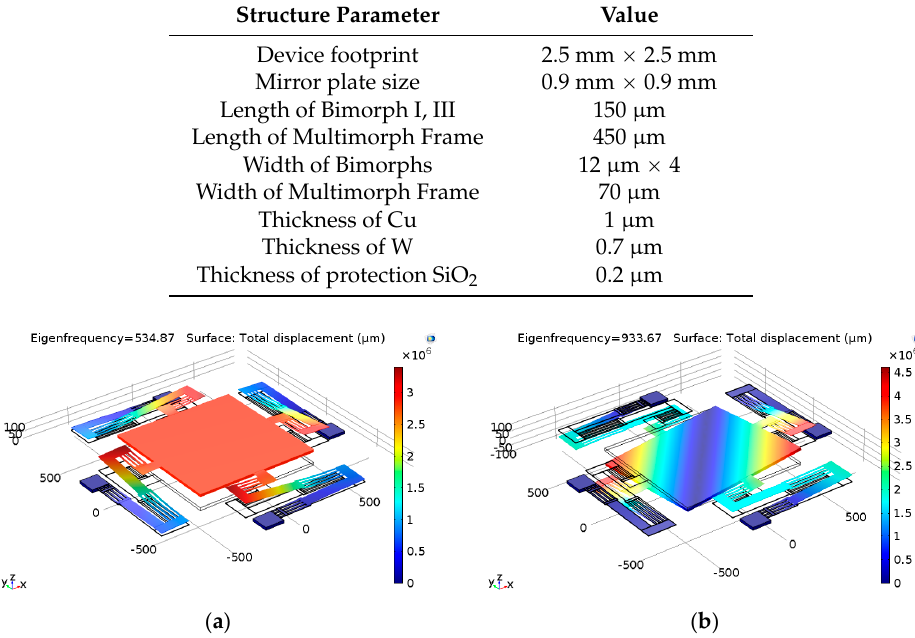
Figure 4. Modal simulation results of the Cu/W LSF MEMS mirror using COMSOL. ( a ) First piston mode, the resonance is 535 Hz; ( b ) Second tip-tilt mode, the resonance is 934 Hz.